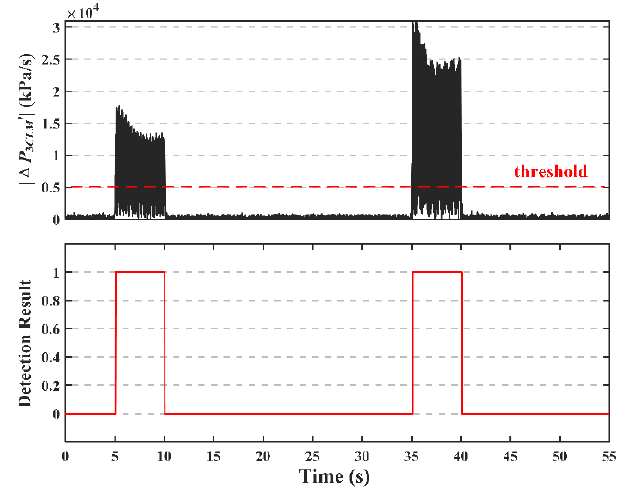
Figure 16. The absolute value of fluctuating pressure change rate ( | ∆ P 3 CLM (cid:48) | ) and the surge detection results.